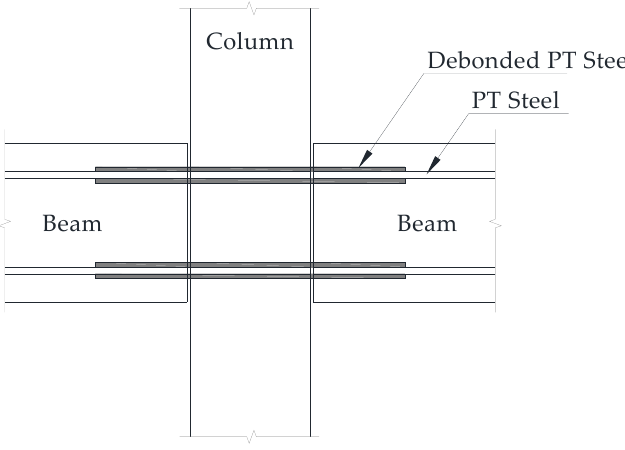
Figure 5. PT connection with unbonded strands [26].